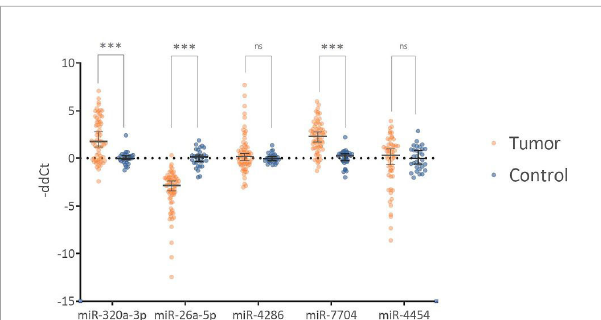
expression and were discarded. The edgeR algorithm identi fi ed 75 miRNAs, the voom algorithm identi fi ed 19 miRNAs and the last algorithm DESeq2 identi fi ed 27 miRNAs that were statistically signi fi cantly differentially expressed. The intersection of all three algorithms identi fi ed 8 differentially expressed miRNAs: miR-320a- 3p, miR-26a-5p, miR-4286, miR-7704, miR-4454, miR-146a-5p,